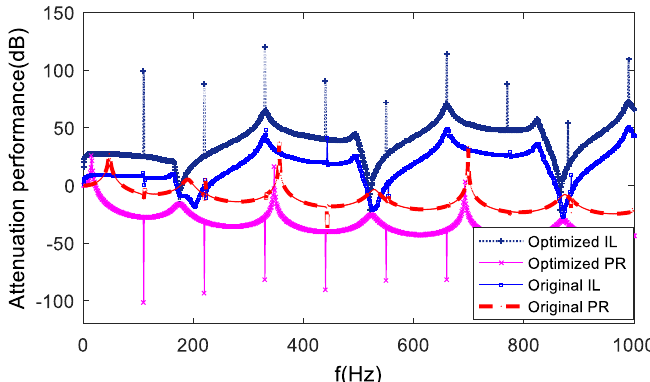
Figure 8. Attenuation performance of single-chamber RSHPA in 3 OF .